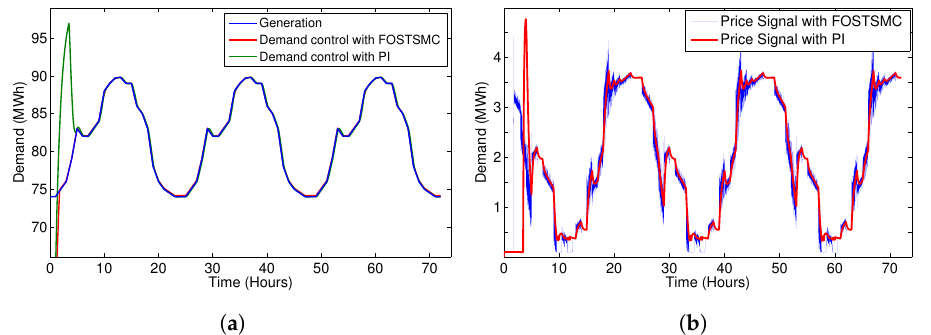
Figure 5. Demand and price response of the proposed framework in scenario. ( a ) Demand Response. ( b ) Price